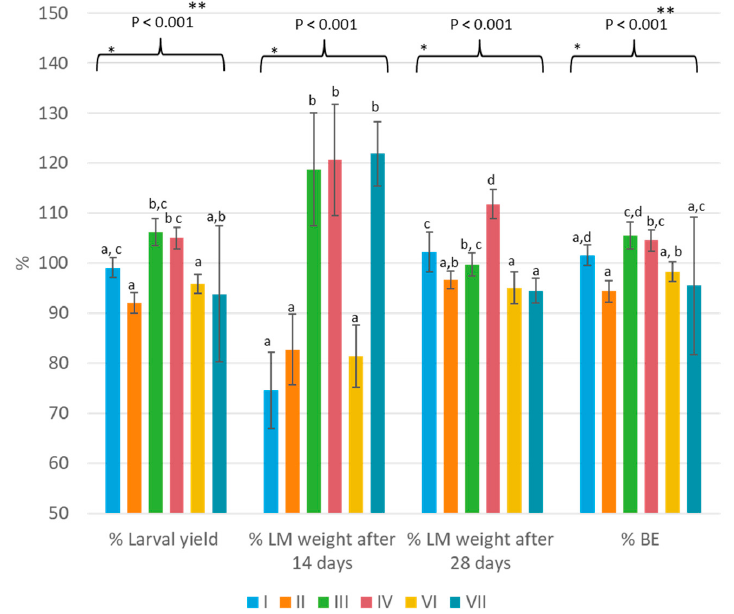
Figure 1. Parameters on growth performance (percentage larval yield, percentage LM weight, and percentage of BE) of the reference diet (wheat middlings supplemented with brewery grains (BG)) for six different trials ( n = 8). The average of six different trials (I, II, III, IV, VI, VII) of the reference diet (each n = 8) was used as the denominator in Equation (2). * Within this data set, averages that are not labeled with the same letter are significantly different on the basis of the ANOVA-Tukey analyses. ** The data showed no equal variances of population, and the Kruskal–Wallis analysis was applied.